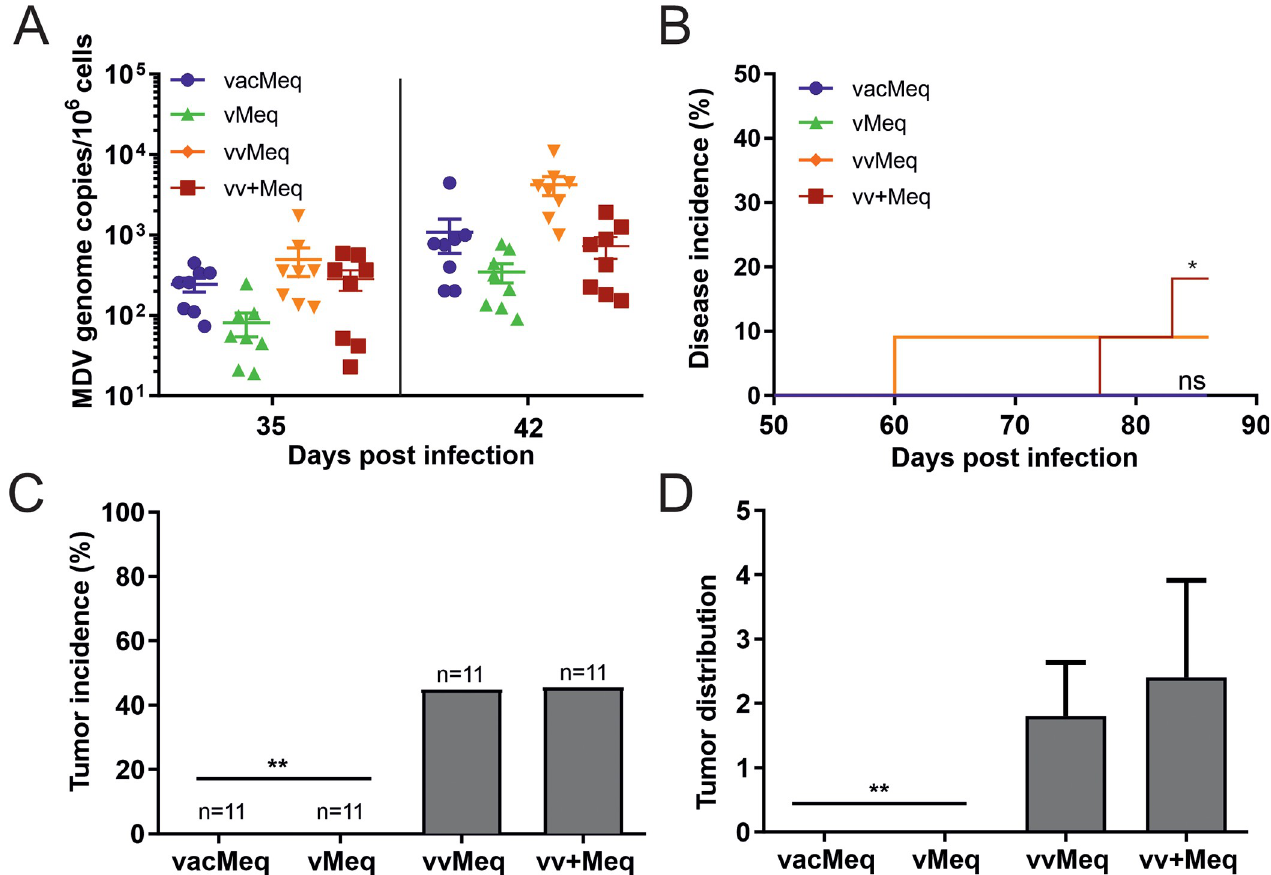
Fig 3. Pathogenesis and tumor incidence in na ï ve contact animals. (A) qPCR analysis of blood samples from naive chickens where MDV genome copies were determined (p > 0.05, Kruskal-Wallis test). (B) Disease incidence in na ï ve chickens infected via the natural route and tumor incidence (C) and tumor distribution (D) are shown for co-housed contact animals. Asterisks ( �� p < 0.0125; Fisher’s exact test) indicate the significant differences in